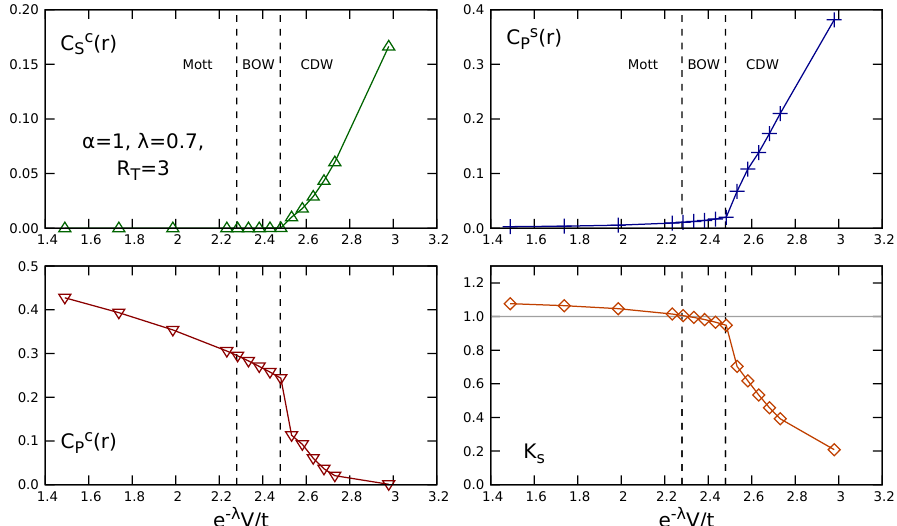
Figure 4. Behavior of the non-local correlation functions in Equation (5) and the Luttinger liquid parameter K s for the Hamiltonian in Equation (13) with dipolar interaction ( α = 3, λ = 0) truncated to third nearest neighbors ( R T = 3) at t = 1 and U = 4 t . The simulations were performed with finite DMRG for a chain of length L = 32, by keeping up to 1200 states and performing six sweeps. The string operator was computed in the middle of the chain r = L /2, while the parity operators were averaged between the two central points L /2 and L /2 + 1.